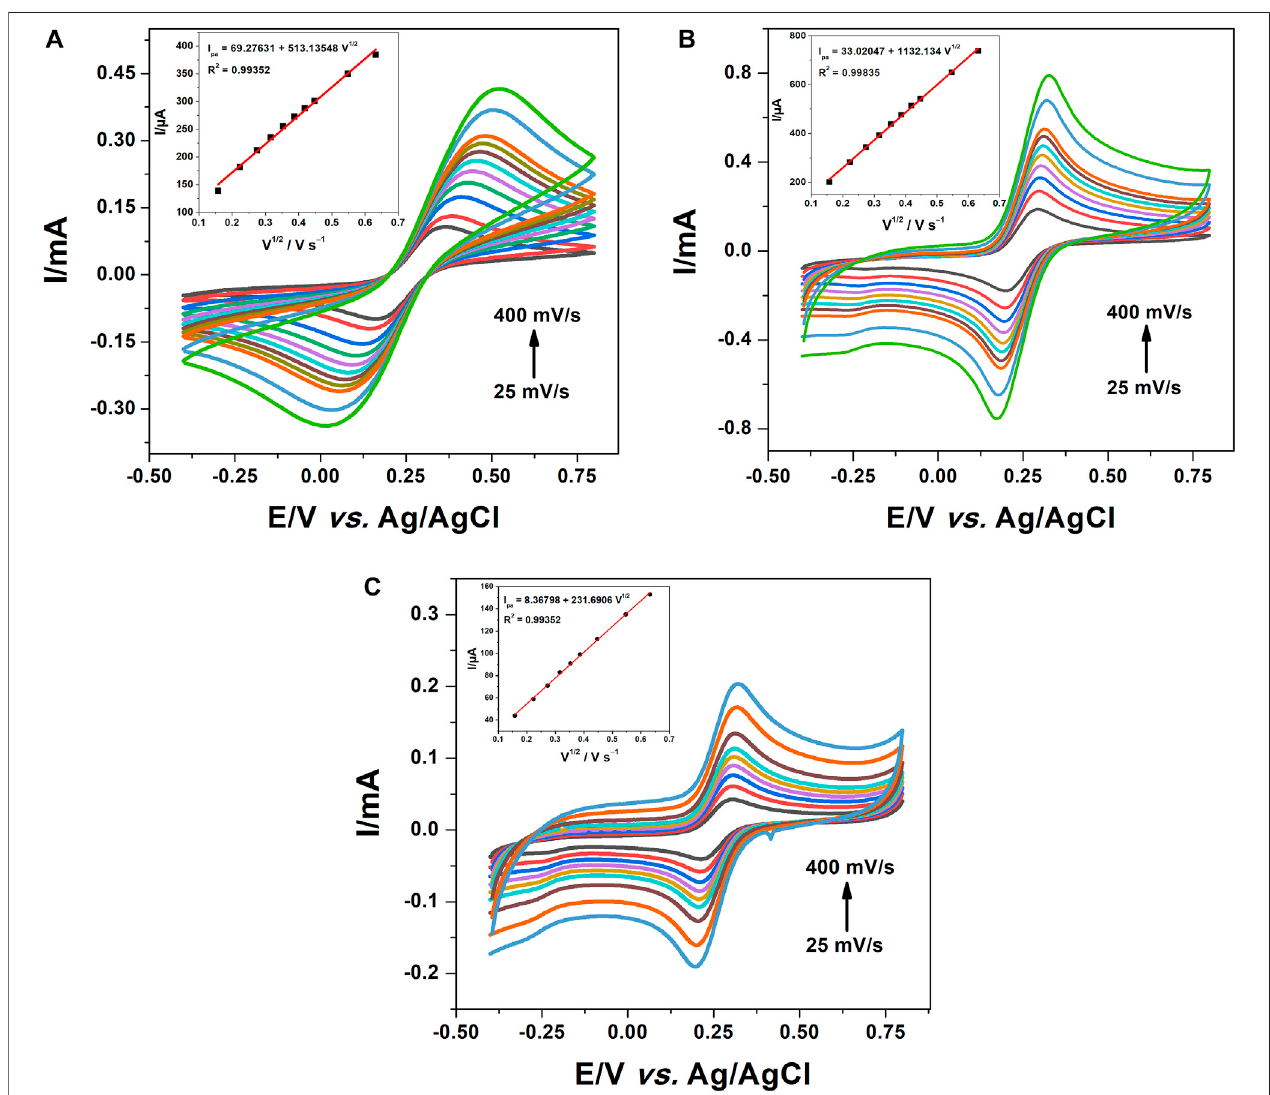
FIGURE 5 | CV of (A) CPE, (B) f-MWCNT/CPE, and (C) poly 1,8-DAN/f-MWCNT/CPE in 0.5 M of KCl containing 10 mM of [Fe(CN) 6 ] 3 − /4 − at different scan